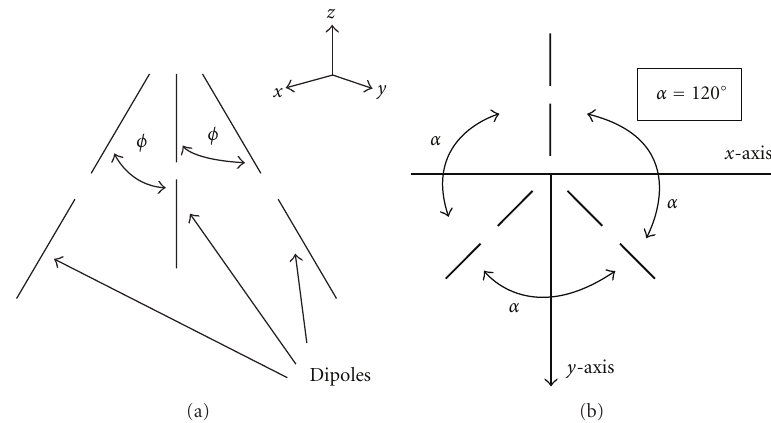
Figure 11: The 3 × 3 MIMO antenna structure for maximizing the mean capacity by rotation of the antennas, parallel at the transmitter and the receiver units, from the z -axis toward x − y plane (it is opened like an umbrella).